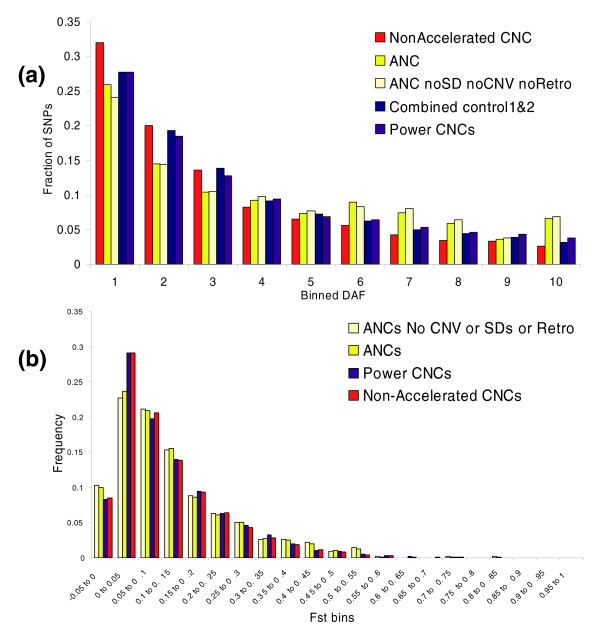
Patterns and levels of nucleotide variation in ANC sequences. (a) The comparative derived allele frequency (DAF) spectrums for phase II HapMap single nucleotide polymorphisms (SNPs) in nonaccelerated conserved noncoding (CNC) sequences (n = 48,811), accelerated noncoding (ANC) sequences (n = 682), ANC sequences outside of segmental duplications, copy number variants (CNVs), retroposed genes or pseudogenes (n = 610), in the two controls (n = 28,408 and n = 28,722), in the power CNC sequences (n = 10,882), and in the 60 individuals of the Yoruban (YRI) population. (b) The comparative distributions of FST values for all phase II HapMap SNPs in ANC sequences (n = 688), ANC sequences outside of segmental duplications, CNVs, retroposed genes or pseudogenes (n = 620), power CNC sequences (n = 11,267), and nonaccelerated CNC sequences (n = 52,210).